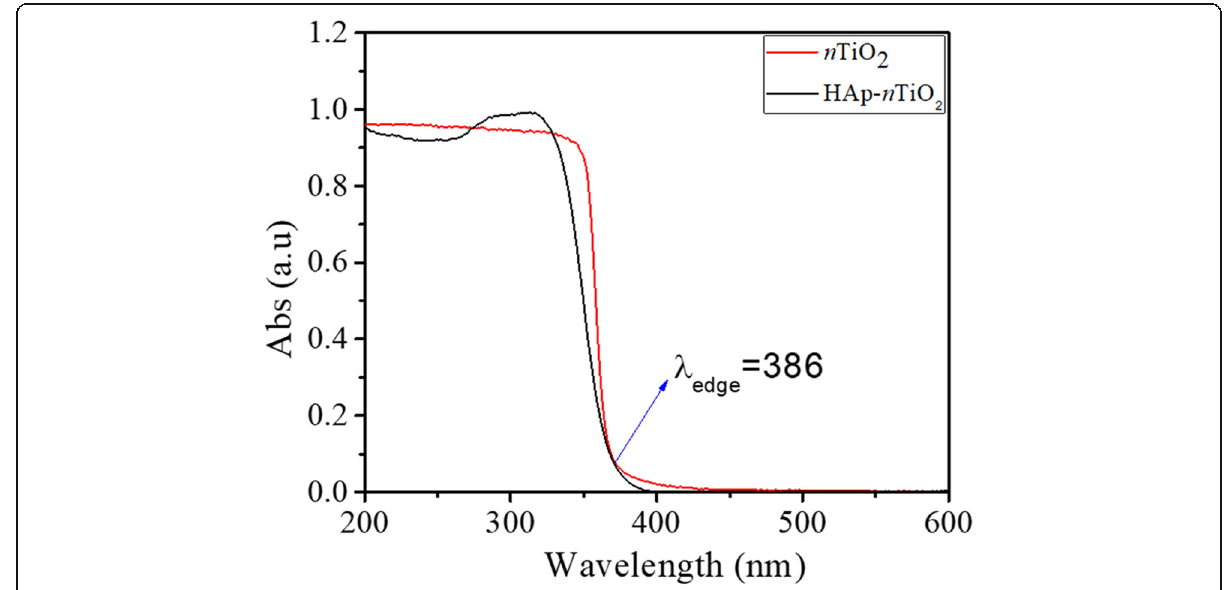
Fig. 5 DRUV- Visible spectra of HAp- n TiO 2 and TiO